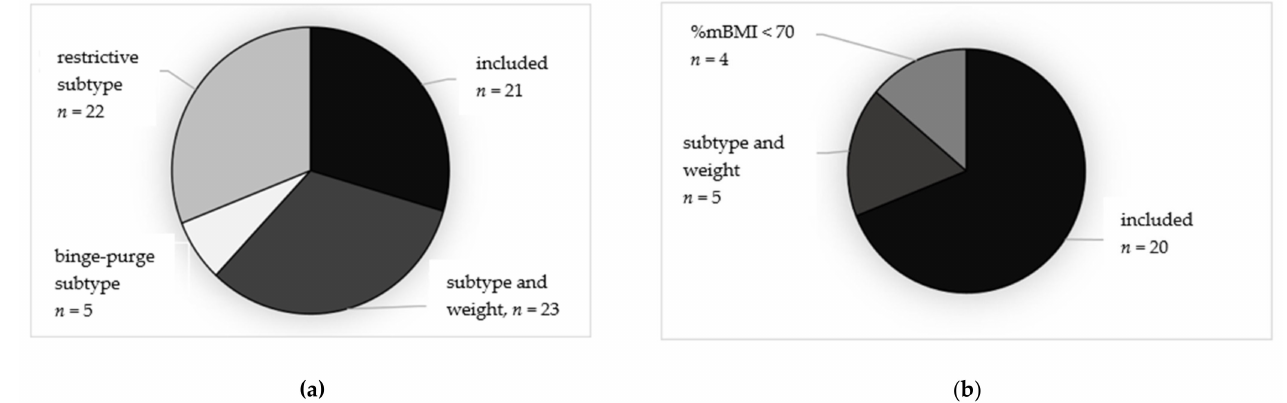
Figure 2. ( a , b ) Distribution of included and excluded patients in the FBT (( a ), left) and IMT (( b ), right) samples. AN, anorexia nervosa; FBT, family-based treatment with/without medical stabilization as needed; IMT, inpatient multimodal treatment followed by outpatient care; %mBMI, percent median body mass index; AN restrictive + %mBMI 70–85, all patients with restrictive subtype and %mBMI 70-85 were included into the subgroup; Atypical AN, excluded due to atypical AN; AN binge-purge, excluded due to binge-purge subtype; AN restrictive + %mBMI >85, restrictive AN subtype, but excluded due to %mBMI > 85; %mBMI < 70 = restrictive AN subtype, but excluded due to %mBMI < 70.